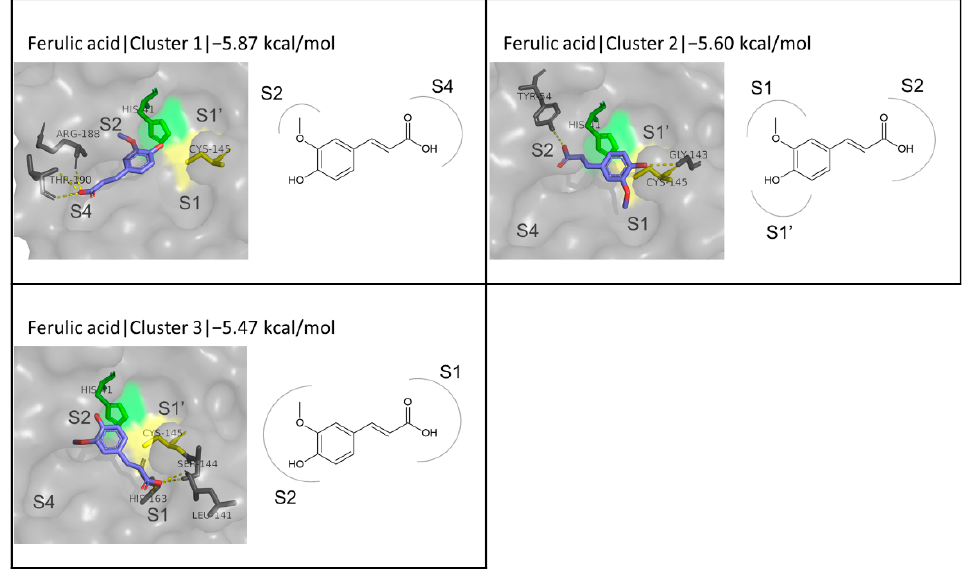
Figure 3. Binding of FA to the active site of M pro . The first three clusters resulting from the simulation are presented. are